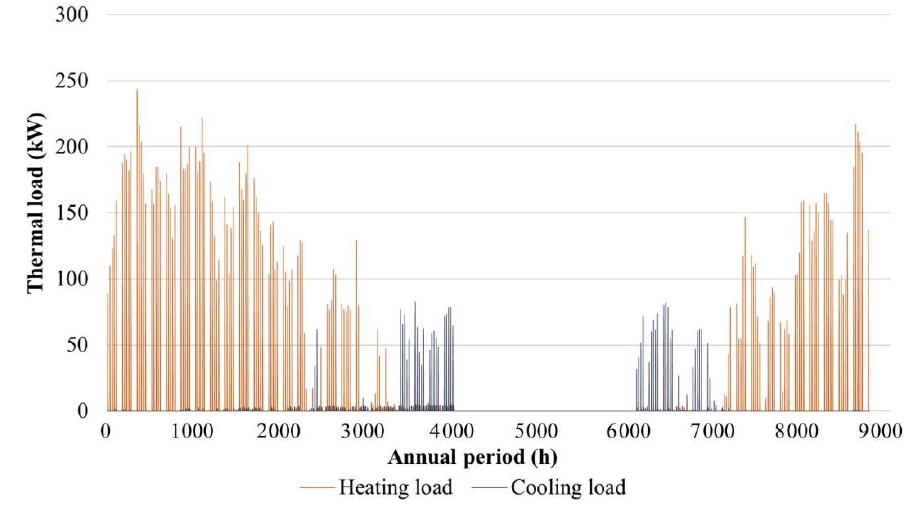
Figure 7. Annual time series of the heating and cooling loads of the examined school building.